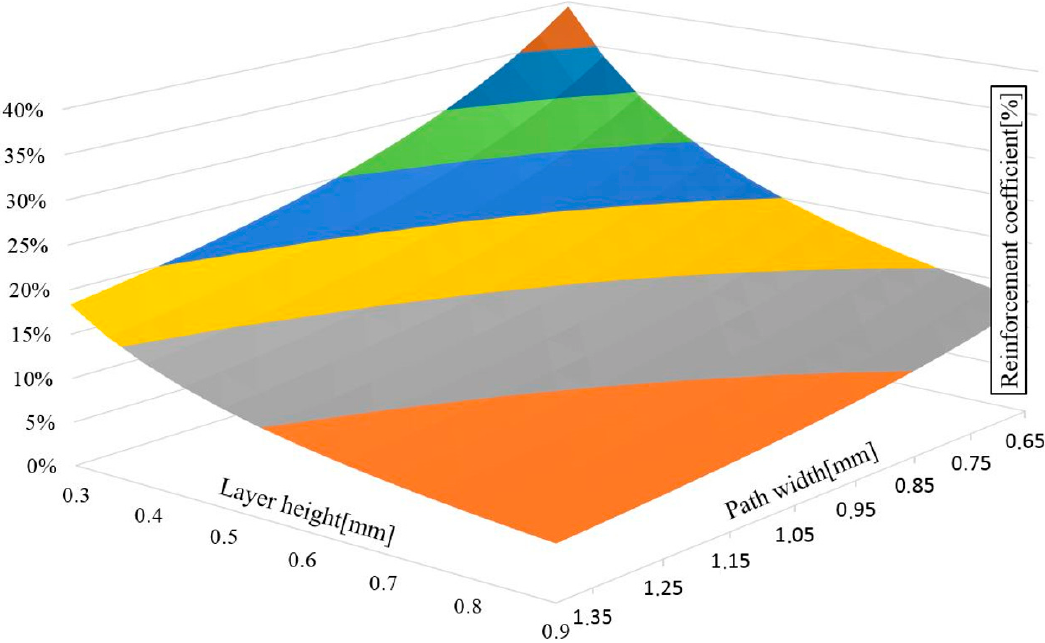
Figure 3. The effect of path height and width on the fiber content factor.